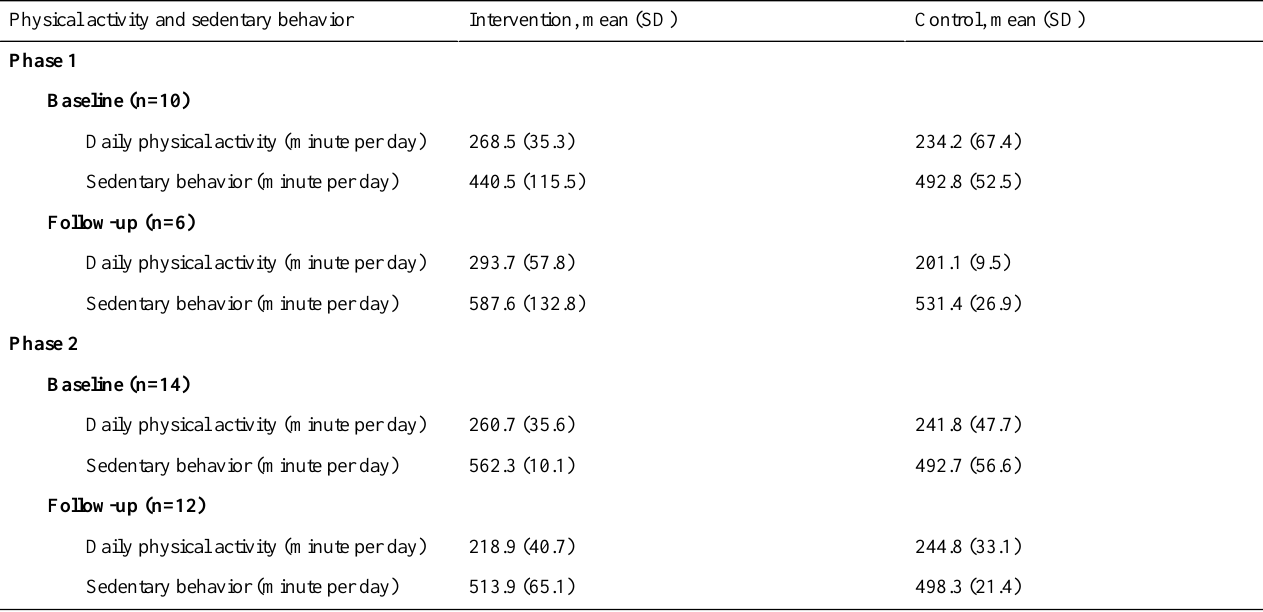
Table 3. Change in accelerometer measured physical activity and sedentary behavior across the Intelligent Personal Assistant Project study (adults).